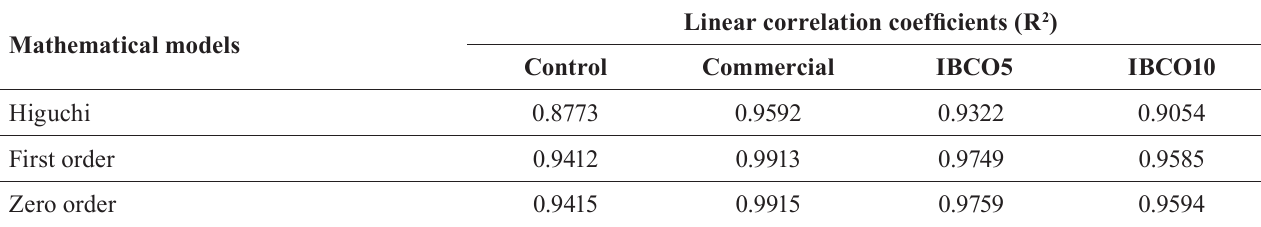
TABLE IV - Cutaneous permeation kinetic patterns of IBU and their linear correlation coefficients (n=3) Mathematical